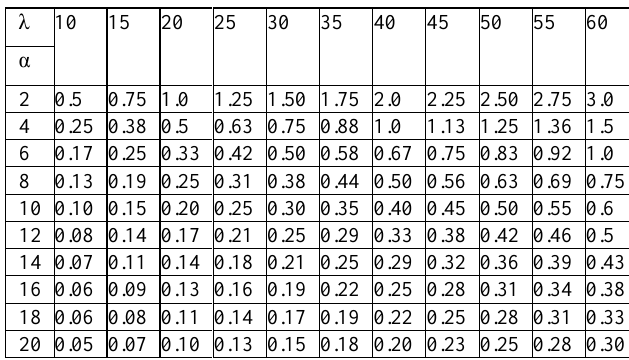
Table 1. Values of the characteristic size Ld of the machine part (units), to reduce the dimension of the mathematicals task.